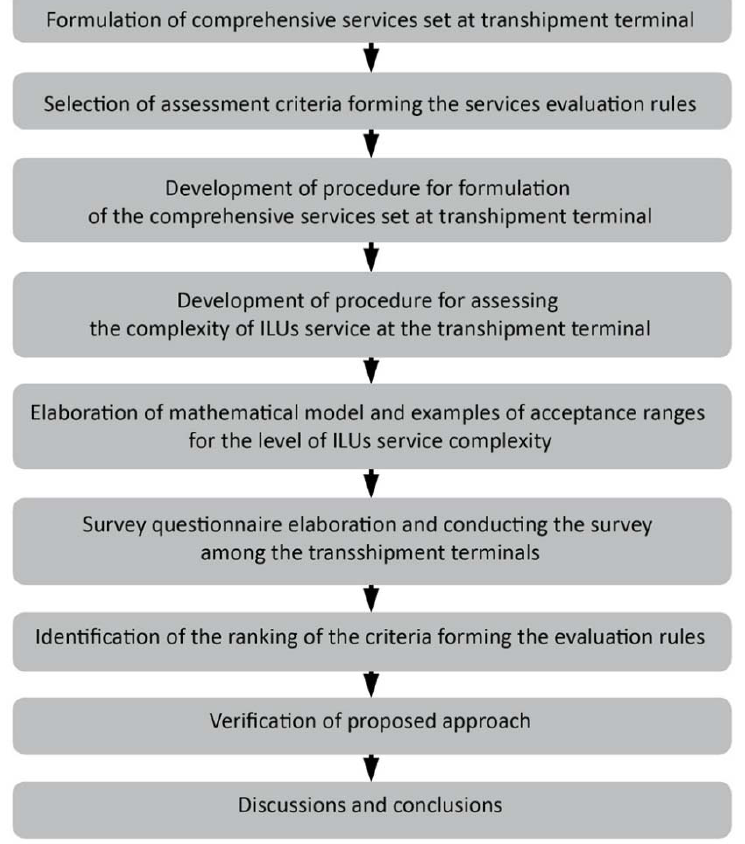
Figure 1. Steps of the research methodology.